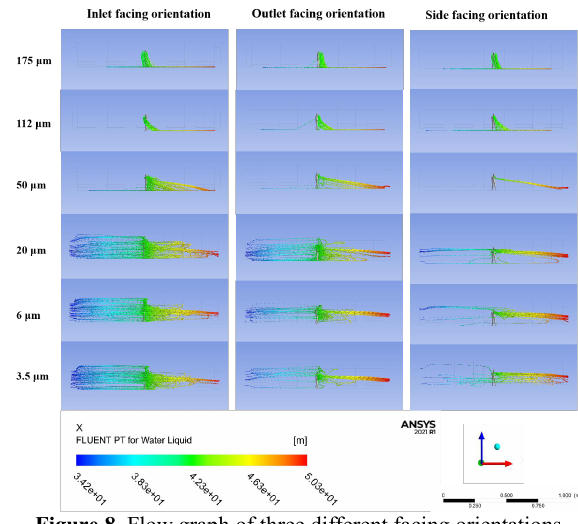
Figure 8 . Flow graph of three different facing